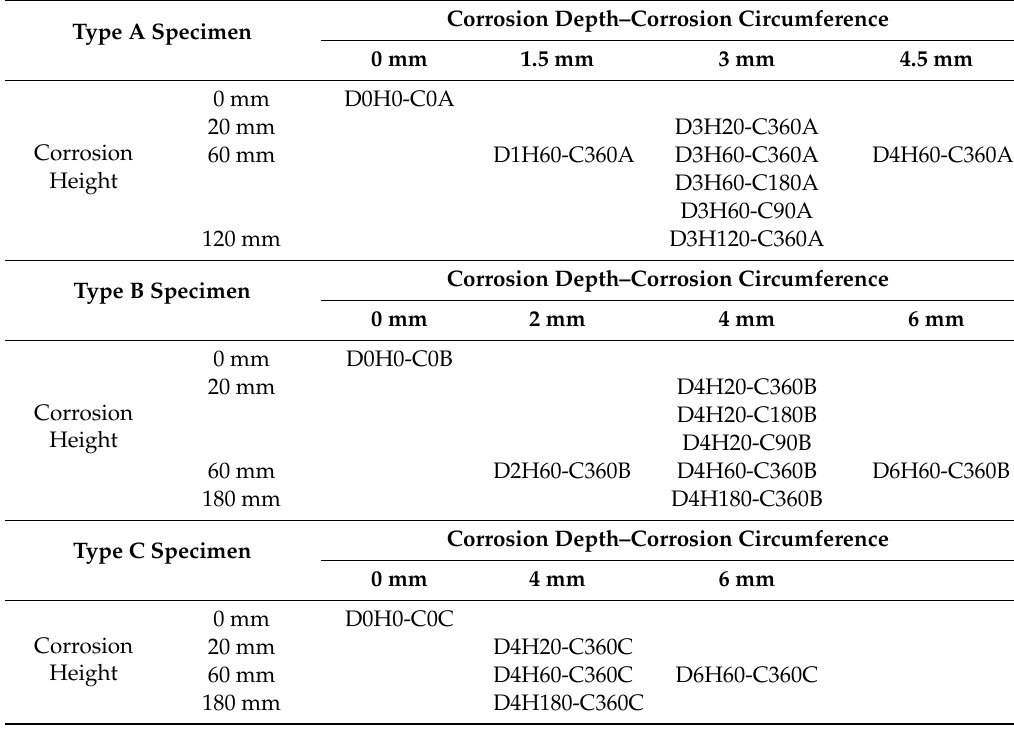
Table 2. Corrosion data of experimental